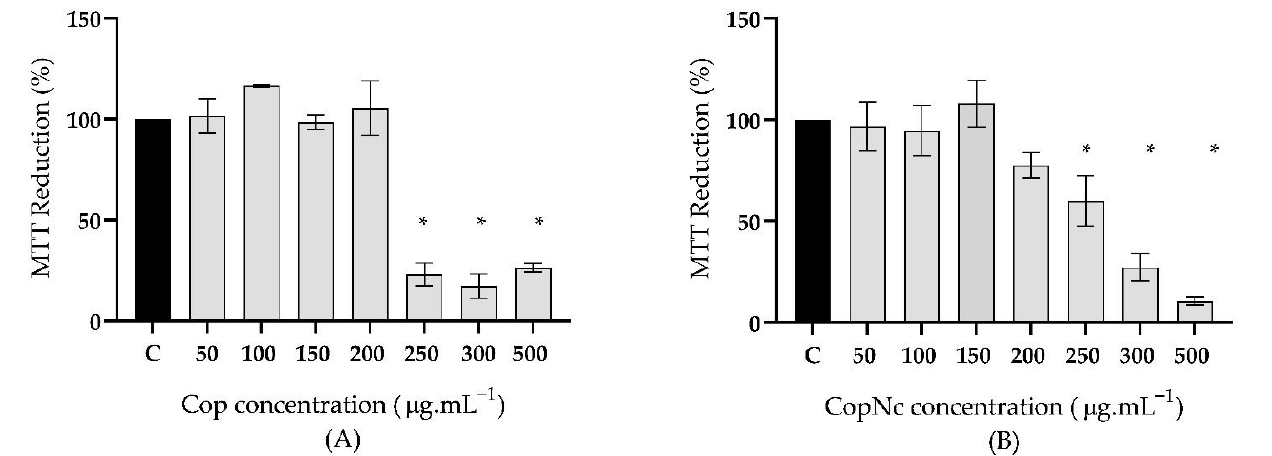
Figure 4. MTT reduction (%) of A549 cells after 24 h of treatment with free copaiba oil (Cop) ( A ) and copaiba oil-loaded nanocapsules (CopNc) ( B ) at concentrations from 50 to 500 µ g · mL − 1 based on the theoretical amount of Cop; *: p < 0.05.